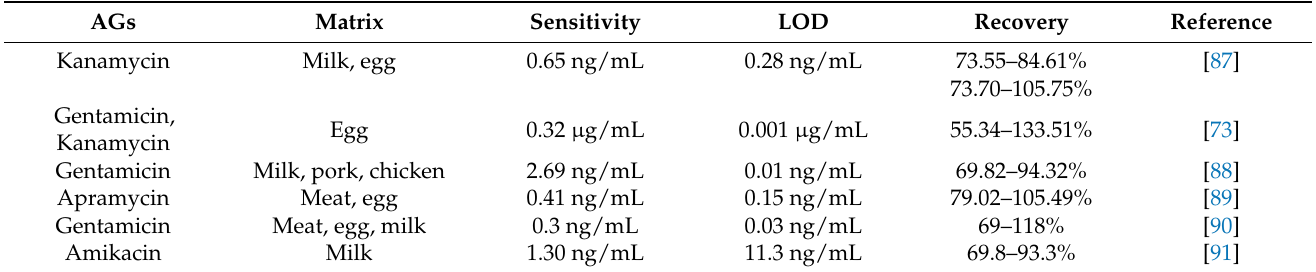
Table 4. Application of ELISA detection of AGs residues in the animal-derived